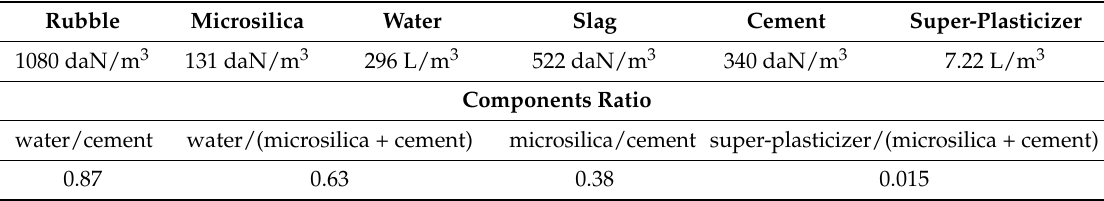
Table 3. Composition of slag and microsilica (SF) concrete mix per unit of volume and component ratios utilized.